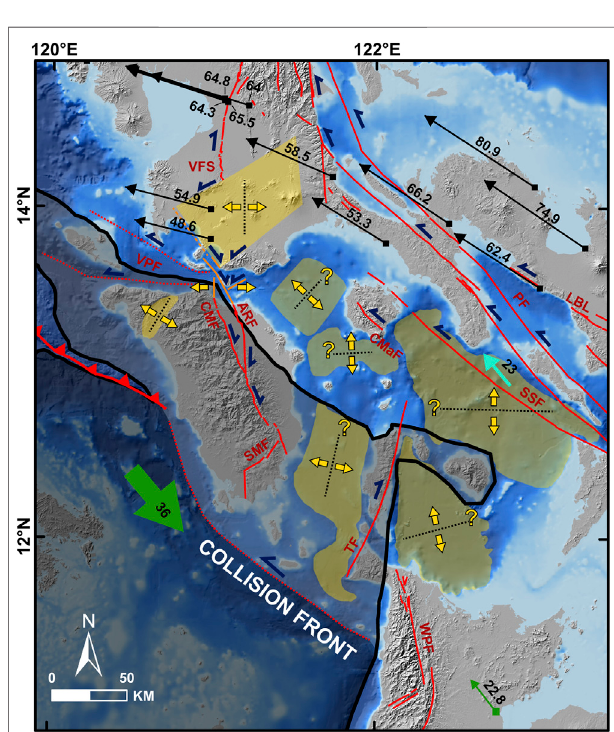
FIGURE13| Ongoingextension innorthernCentralPhilippinesbecause of differential northwestward block motion. Basins are delineated in yellow. Thedirectionofextensionforthebasinsarefromthestructuralinterpretationin Macolod Corridor (Pubellier et al., 2000) and T axes from GCMT